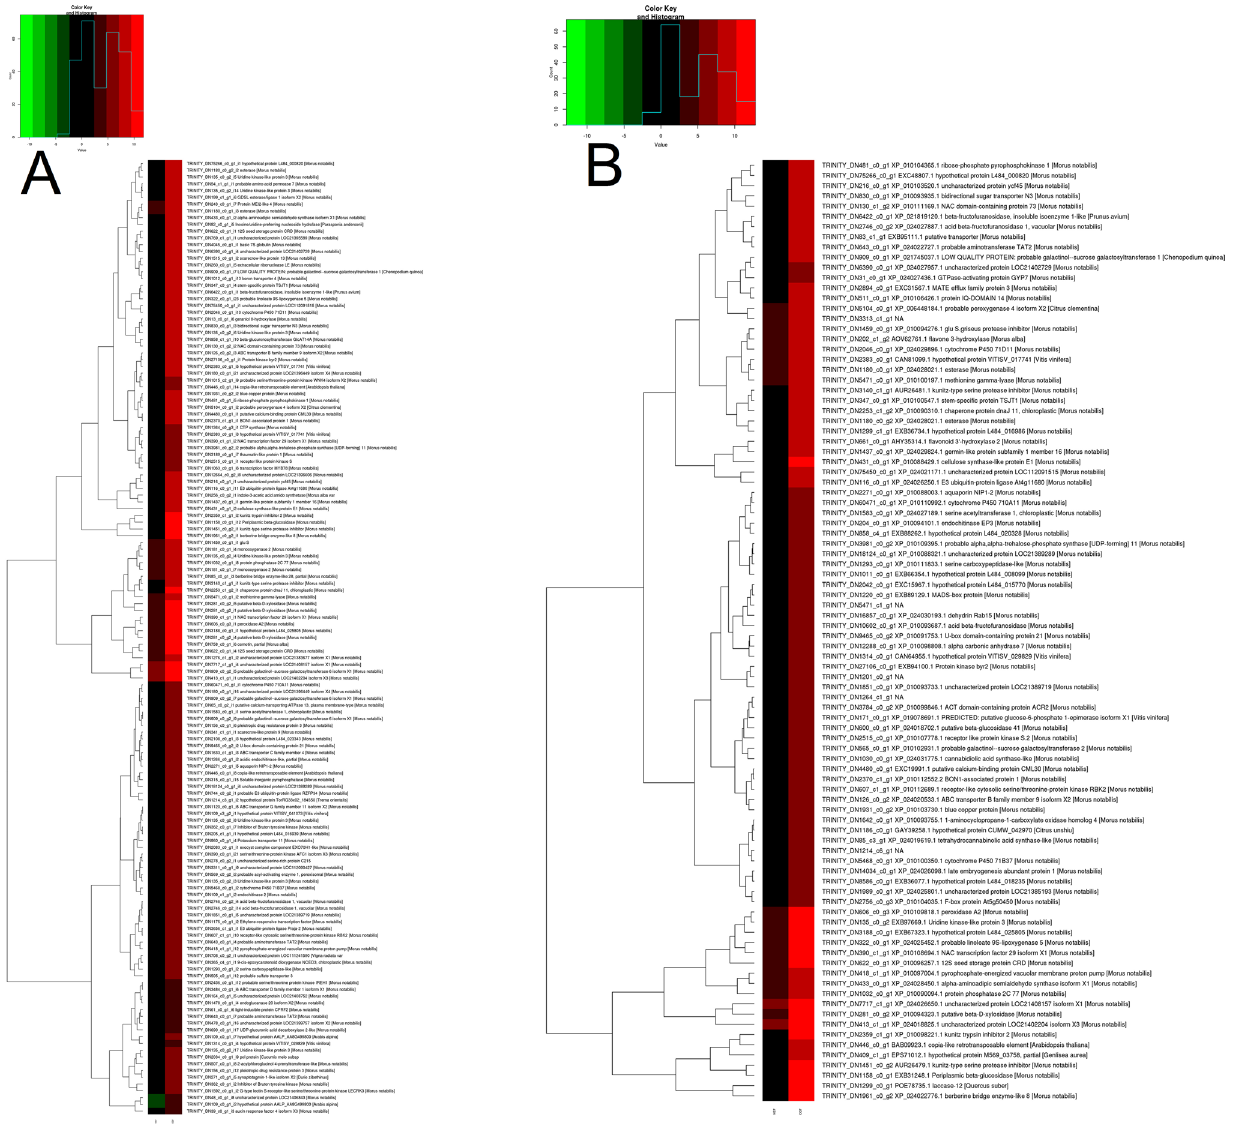
Figure 11. Hierarchical clustering of differentially expressed top 5% down-regulated ( A ) isoforms and ( B ) unigenes in relation to NS7 vs CO7. The higher score with different colour represents the higher level of